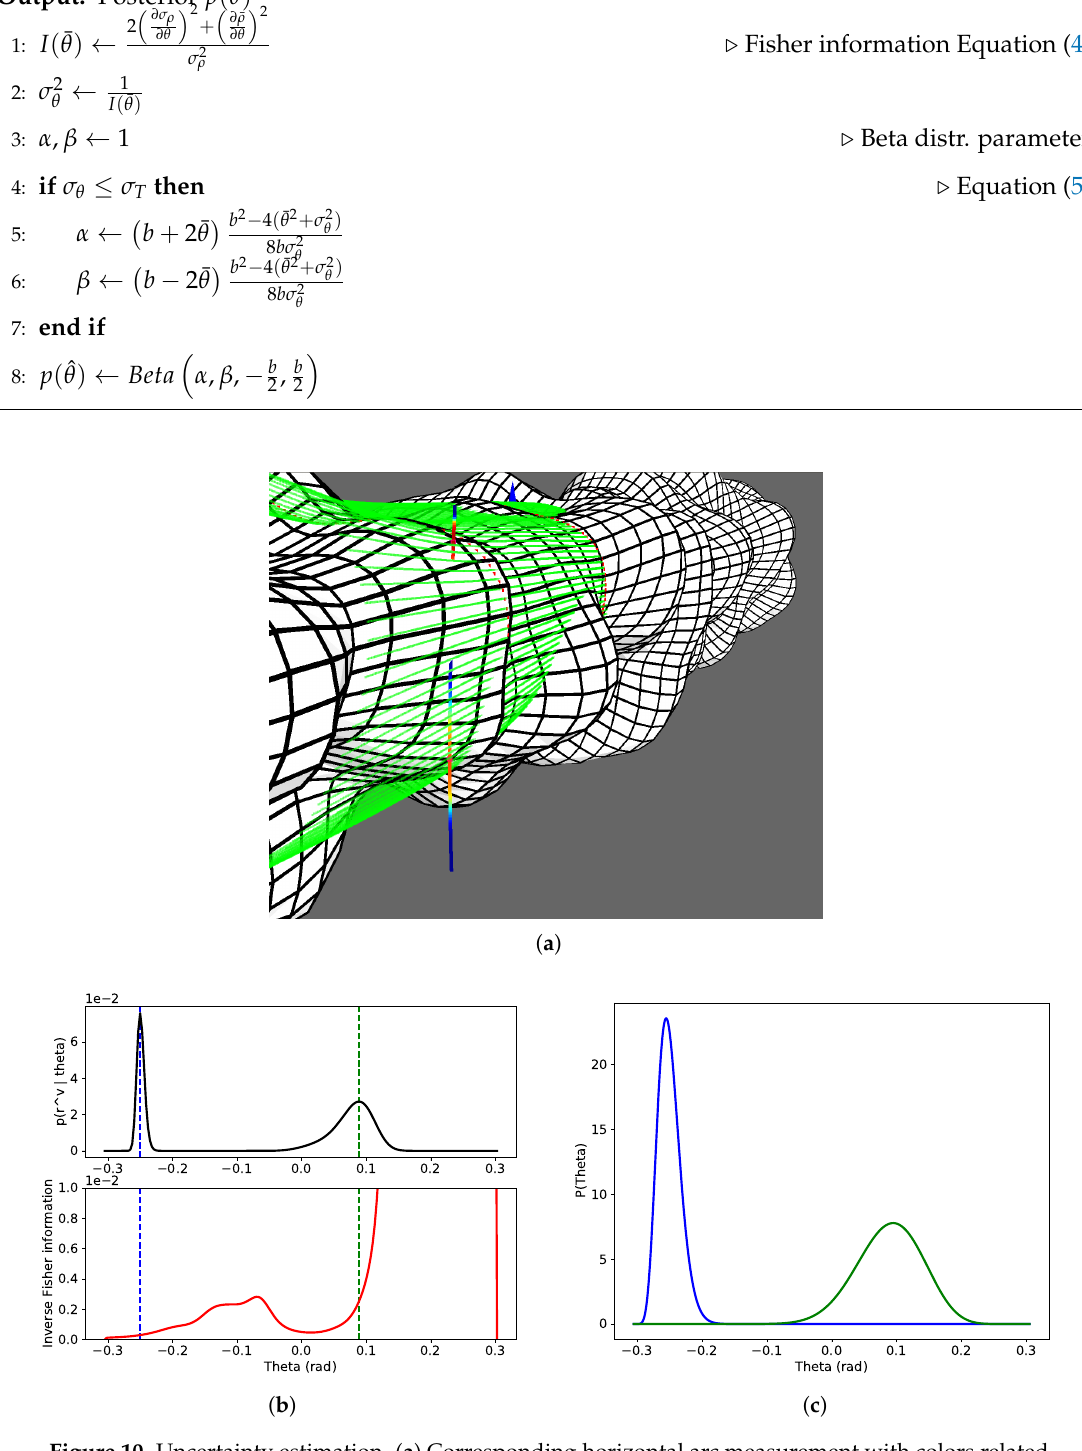
Figure 10. Uncertainty estimation. ( a ) Corresponding horizontal arc measurement with colors related to the beta pdf values. The top (resp. bottom) distribution correspond to the blue (resp. green) curve in the figure below. ( b ) Graphics for θ likelihood (top) and inverse fisher information (bottom). ( c ) Beta distributions corresponding to the two local